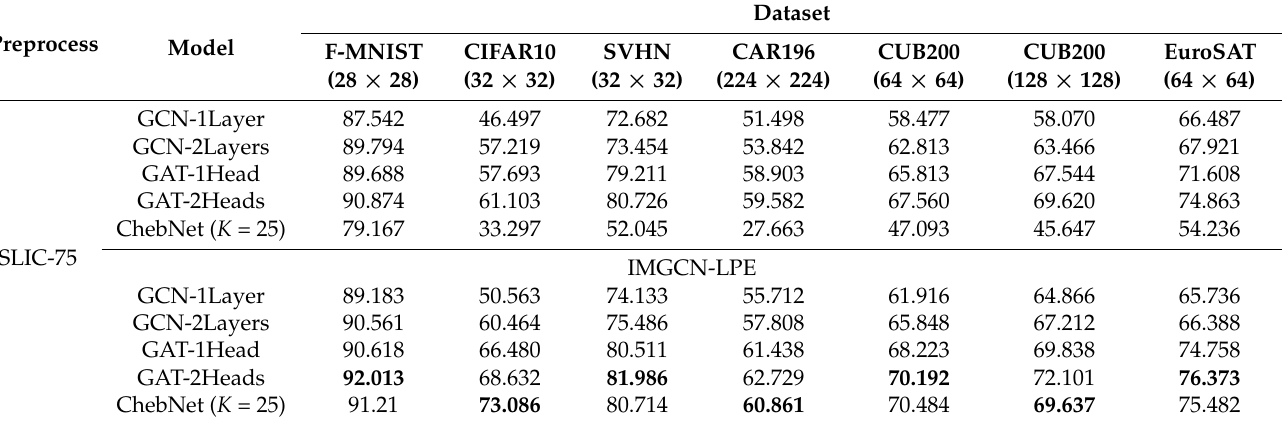
Table 1. Detailed experimental results of baseline models (Chebyshev graph convolutional net- work (ChebNet) of aggregating maximum K = 25 neighbors information, graph convolutional net- work(GCN) with stacking single layer (1Layer) or two layers (2Layers), and graph attention network (GAT) with single head (1Head) or two multi-heads attention (2Heads)) and IMGCN-LPE applied to SLIC-75 images.